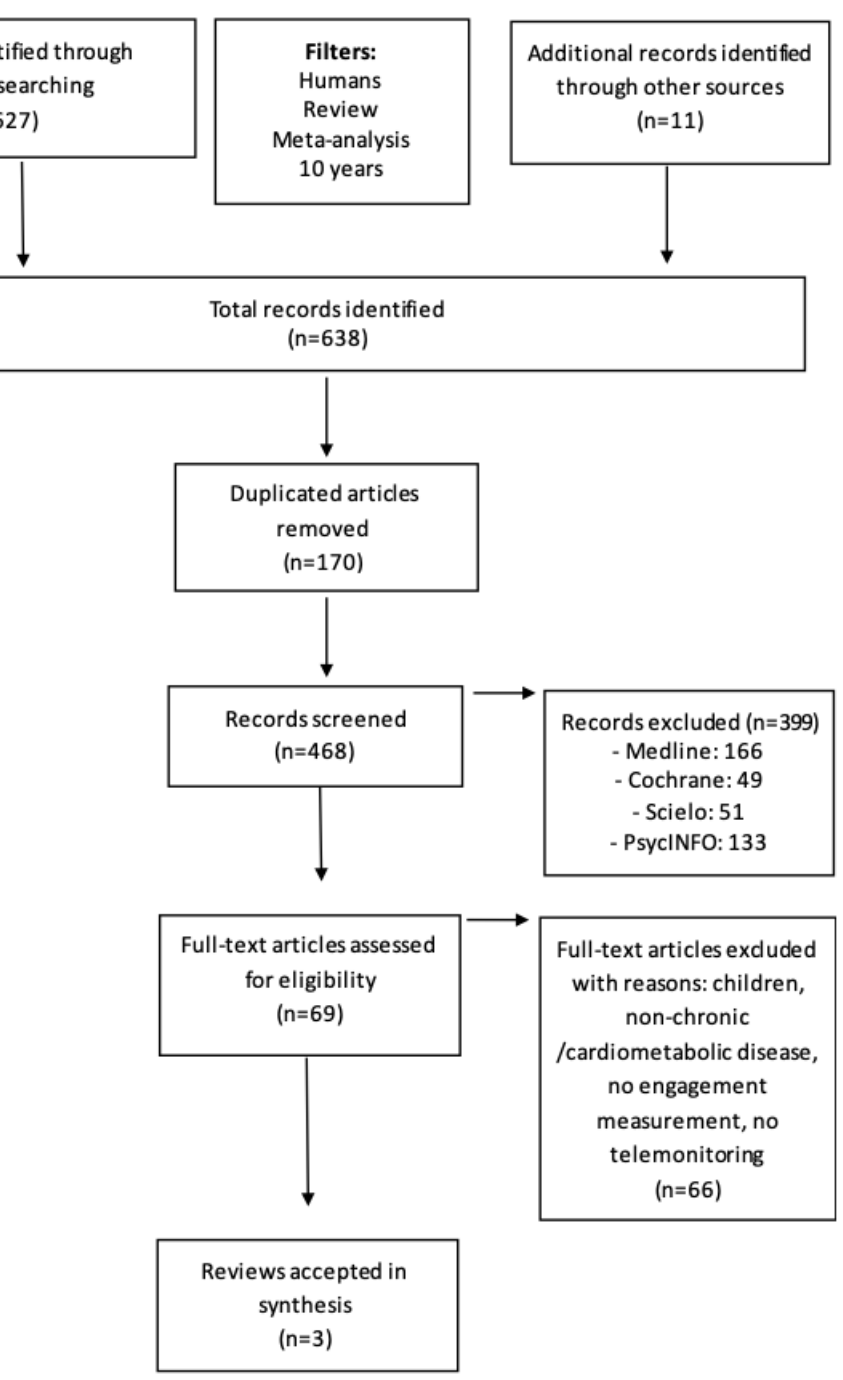
Figure 1. Flowchart of article selection